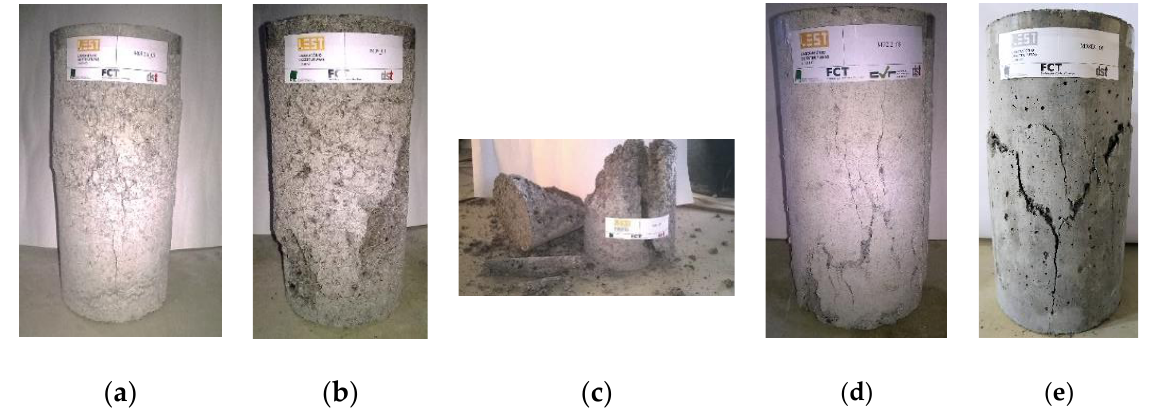
Figure 13. Failure modes obtained after compression tests: ( a ) failure mode of EAFS3A mixture; ( b ) and ( c ) failure mode of EAFS4 mixture; ( d ) and ( e ) representative failure modes of EAFS6, 2, 8B, 3B, 8C, 5C, 8C1, 8D and 8D1 mixtures in accordance with the satisfactory failure modes of the standard [47].